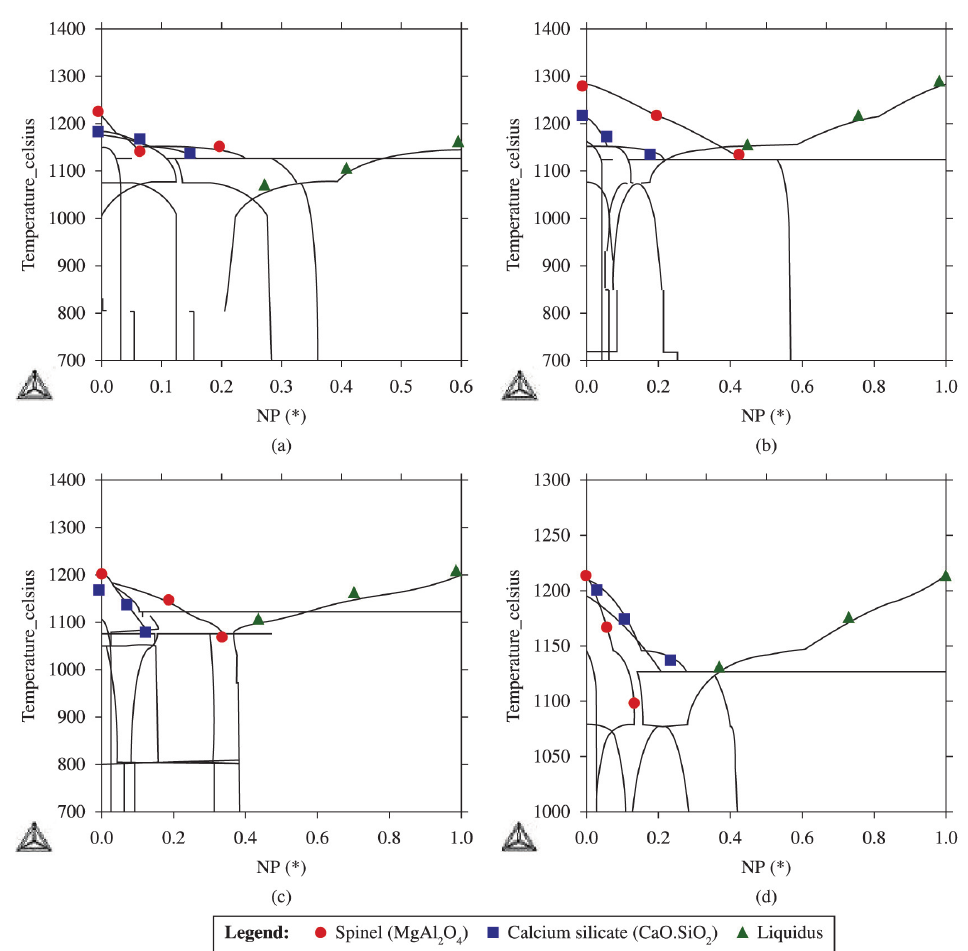
Figure 1. Cooling curves of rock wools fabricated using only granite waste (a), only steelmaking slag (b), both residues (c), and from a industrial sample (d).